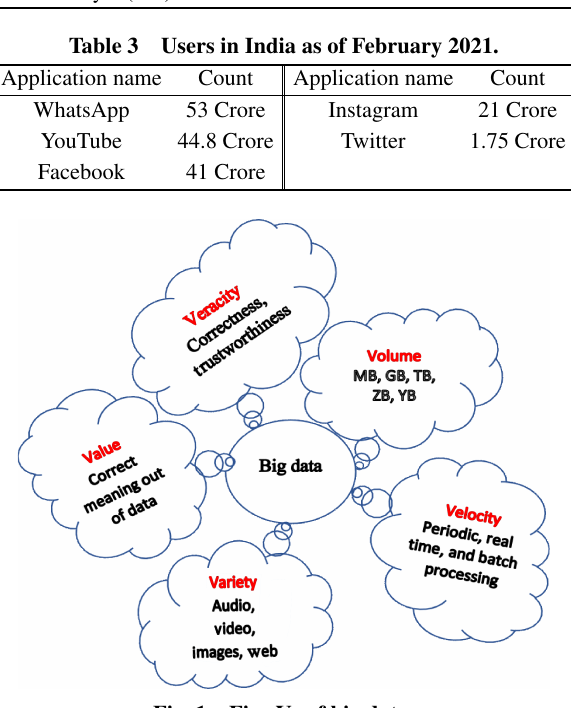
Fig. 1 Five Vs of big